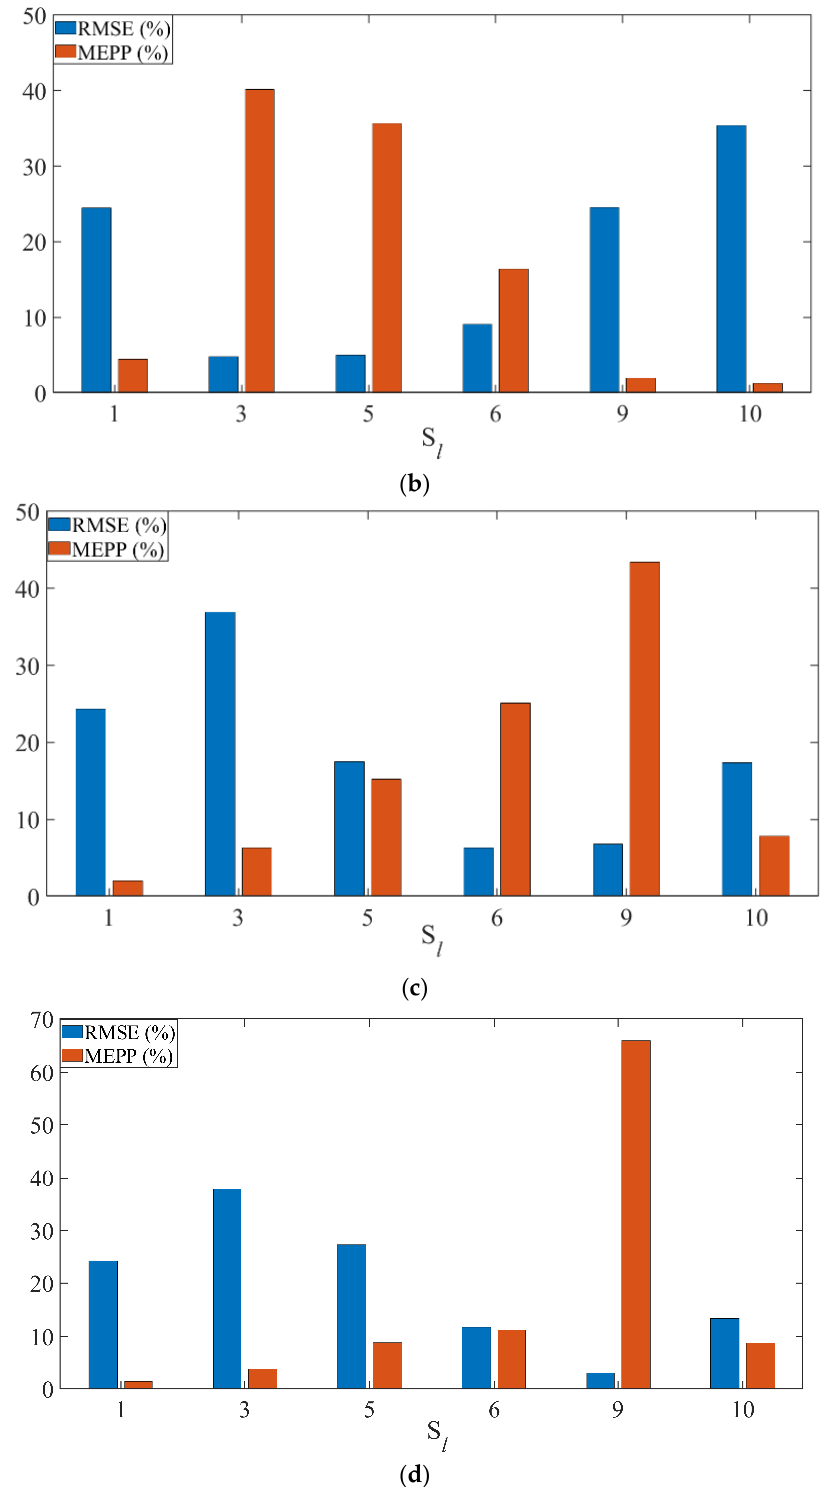
Figure 7. ( a ) GPR models trained by different sample subsets predict the test set S 2 to obtain the corresponding MEPP and RMSE values ( b ) GPR models trained by different sample subsets predict the test set S 4 to obtain the corresponding MEPP and RMSE values ( c ) GPR models trained by different sample subsets predict the test set S 7 to obtain the corresponding MEPP and RMSE values ( d ) GPR models trained by different sample subsets predict the test set S 8 to obtain the corresponding MEPP and RMSE values.